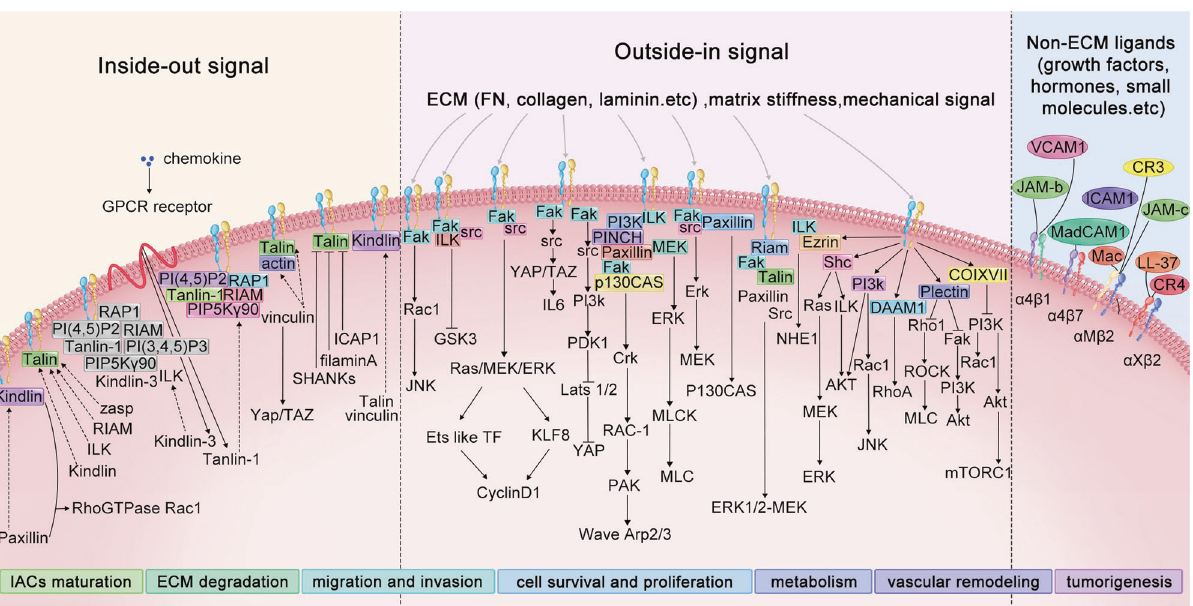
Fig. 4 Schematic overview of integrin activation-associated signaling cascades. Integrin activation is regulated by multiple external signals, such as ECM, mechanotransduction or signaling from non-ECM ligands, including growth factor receptors, hormones, and small molecules, which is termed the “ outside-in ” mechanism. ECM or non-ECM ligand binding and force application results in integrin clustering and initiates downstream signaling to the actin cytoskeleton through recruited talin and vinculin, where actin can simultaneously pull on integrins and further in turn promote force generation. The “ outside-in ” mechanism then triggers various signaling cascades that ultimately result in cell survival, proliferation, cell spreading, and even tumorigenesis and metastasis. On the plasma membrane, there is also an “ inside-out ” mechanism, which regulates the displacement of intracellular integrin inhibitors and allows talin or kindlin binding to integrin β -tails, controlling integrin af fi nity for ECM components. For example, in neutrophils, both Talin-1 and Kindlin-3 are rapidly recruited to activate β 2 integrins induced by extracellular chemokines binding to GPCR (G-protein-coupled receptor). Solid arrows indicate activation, the dotted line indicates recruiting, and the solid blunt end arcs indicate inhibitory